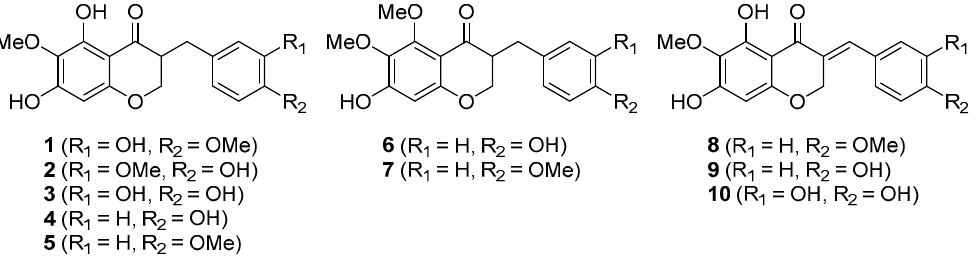
Figure 1. Naturally occurring homoisoflavonoids containing either 5,7-dihydroxy-6-methoxy (i.e., 1 – 5 and 8 – 10 ) or 7-hydroxy-5,6-dimethoxy ( 6 and 7 ).